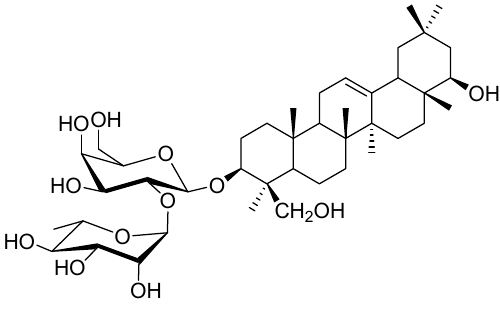
Figure 1. Structure of chickpeasaponin B1.